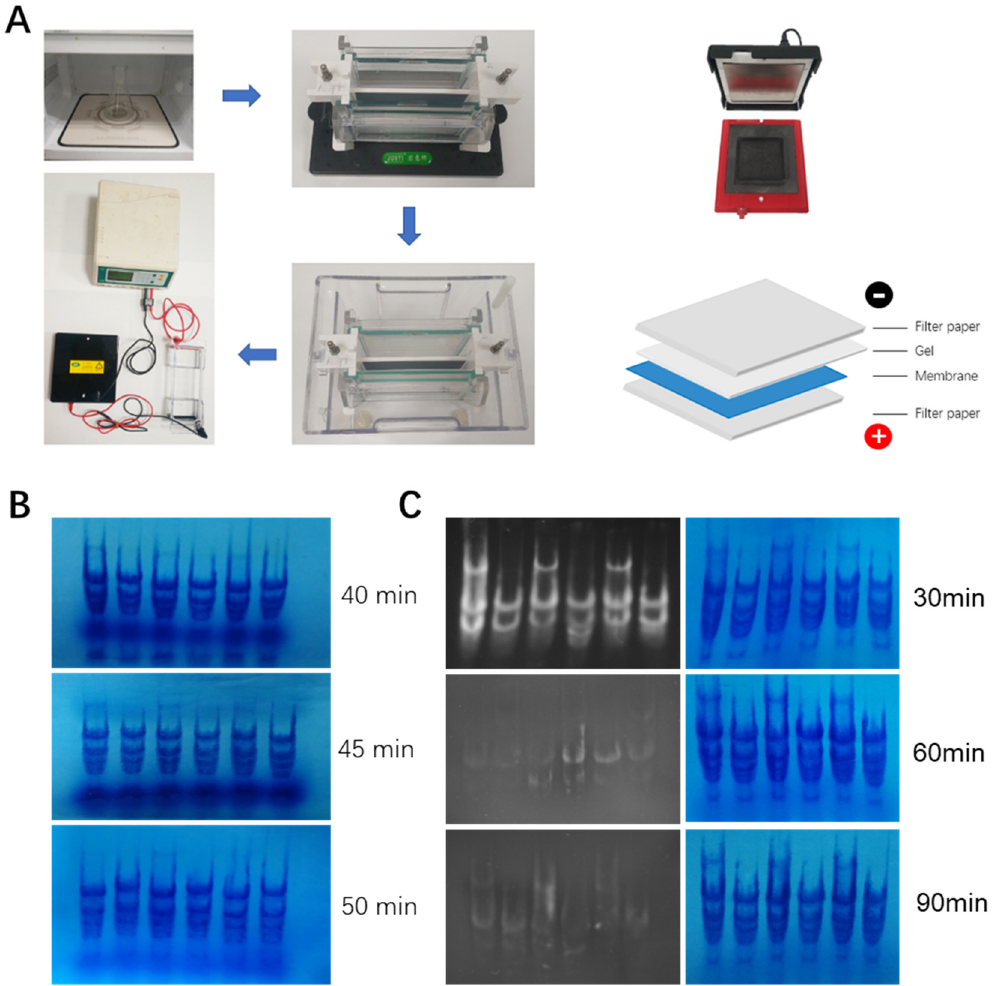
Figure 4. Optimization of gel running and transferring condition. ( A ) Pipeline of new gel running and transferring procedure. ( B ) Bromophenoblue staining of membrane transferred from gels running for different time indicated to the right. A 20 μ g total RNA sample was loaded in each lane. Gel was transferred for 90 min. ( C ) Bromophenoblue staining of membranes after transferring for indicated time (in the right). A 20 μ g total RNA sample was loaded in each lane. Gel was run for 45 min.